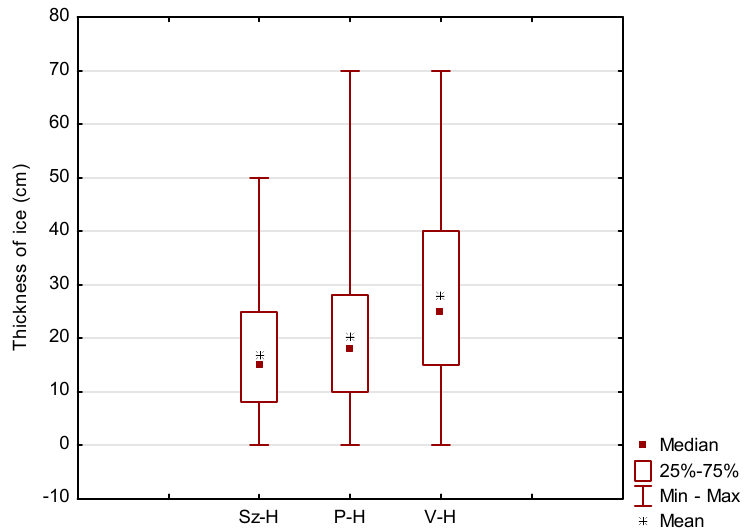
Figure 4. Box and whisker plot, presenting descriptive measures for maximum ice thickness in season (H) on Szczecin Lagoon (Sz–H), Puck Lagoon (P–H), and Vistula Lagoon (V–H) through the period 1950/51–2019/20. Boxes indicate the positions of the lower and upper quartile, and whiskers represent the maximum and minimum values of ice parameters.